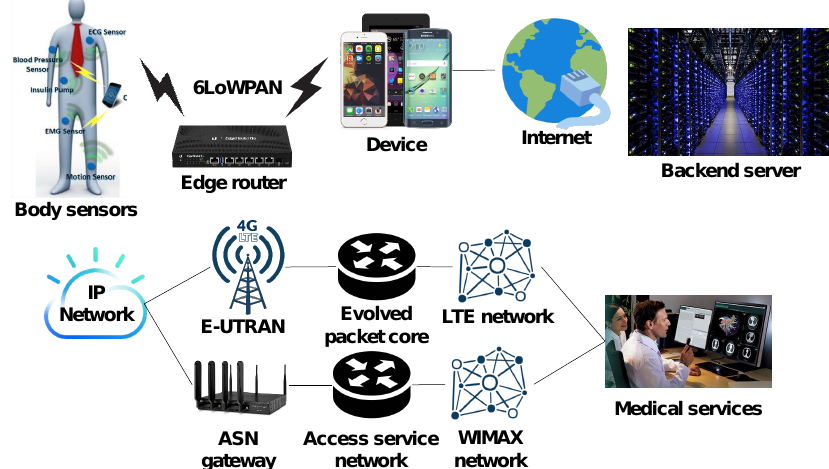
Figure 4. Topology for remote patient monitoring using body sensors (top part) with two standard communication techniques (bottom